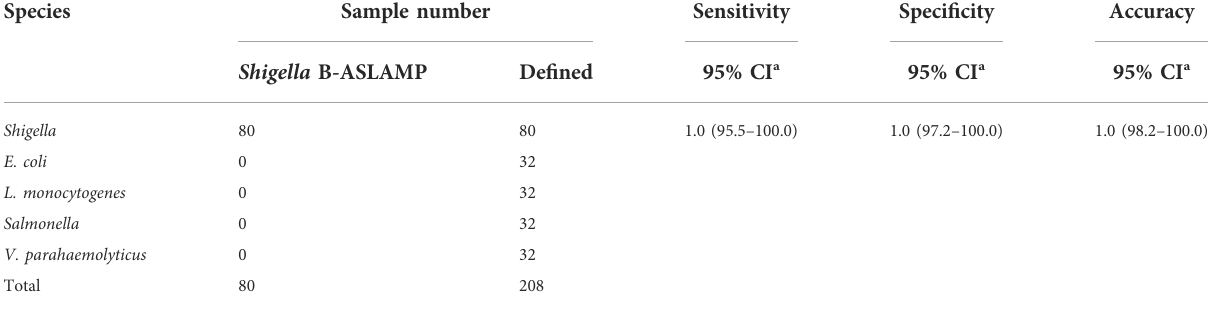
TABLE 1 Sensitivity and speci fi city of B-ASLAMP assay for Shigella .